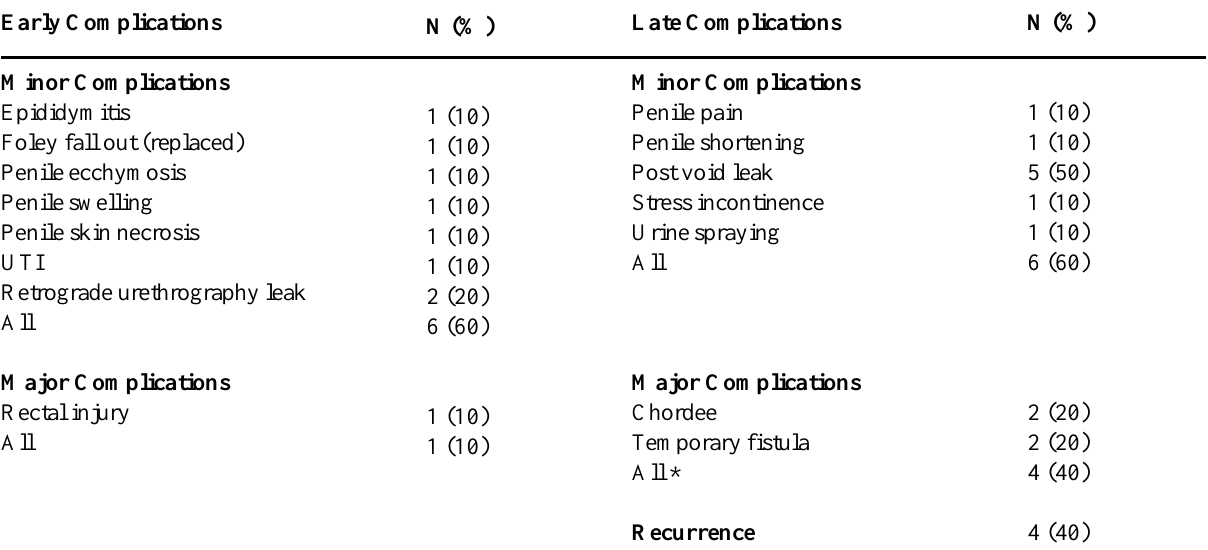
Table 5 – Fasciocutaneous urethroplasty complications, n =